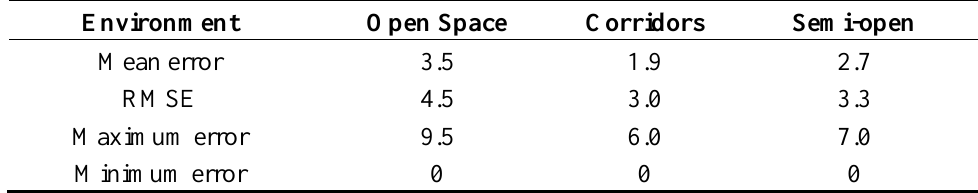
Table 3. Positioning results (Unit: